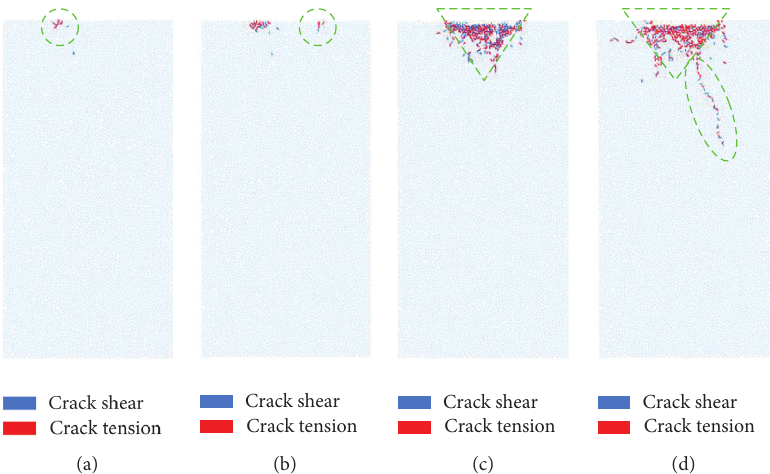
Figure 17: Progressive fracture propagation simulated in PFC 2D. (a) Typical time A. (b) Typical time B. (c) Typical time C. (d) Typical time D.